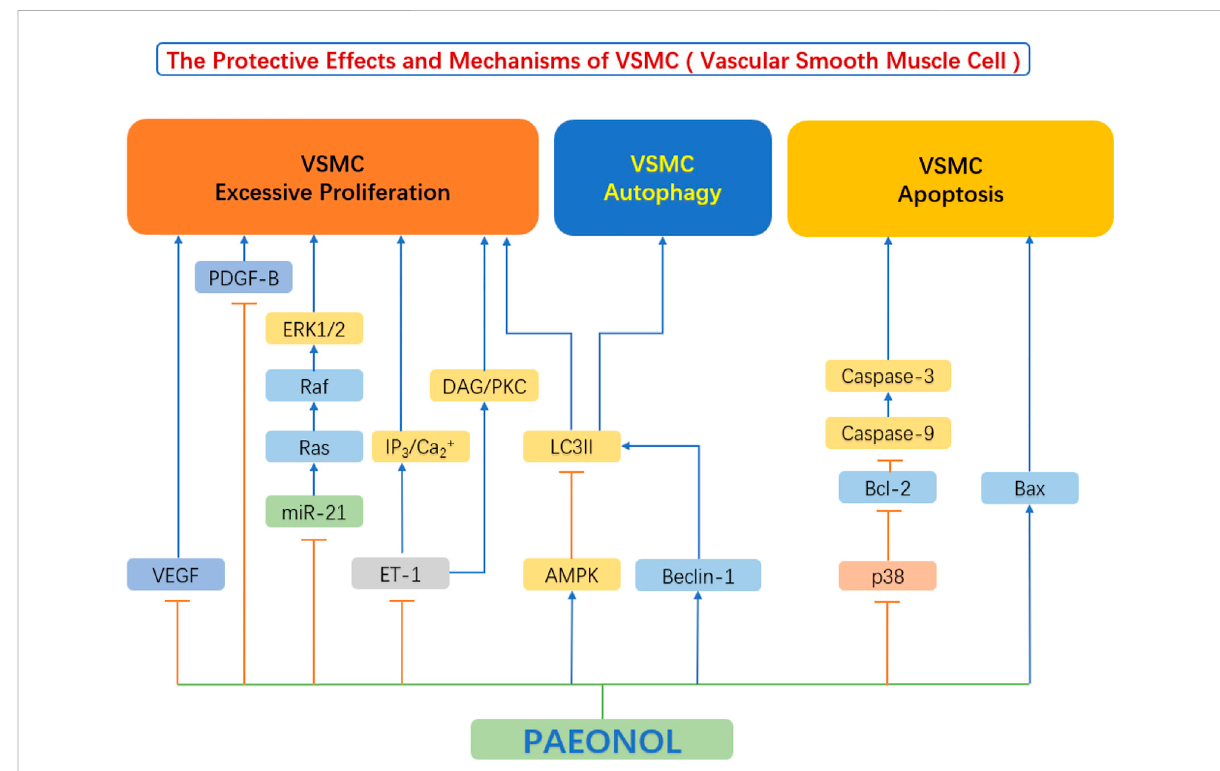
FIGURE 5 The protective effects and mechanisms of paeonol in smooth muscle cells.AMPK, AMP-activated protein kinase; Bax, Bcl-2-associated X protein; Bcl-2, B-cell lymphoma-2;Beclin-1,the mammalian ortholog ofyeast ATG6; Ca, calcium; DAG, diacylglycerols; ERK1/2, extracellular signal regulated kinase 1/2; ET-1, endothelin-1; IP3, inositol 1,4,5-triphosphate; LC3II, light chain 3 II; miR-21, microRNA-21; p38, p38 mitogen-activated protein kinase (MAPK); PDGF-B, platelet derived growth factor B; PKC, protein kinase C; VEGF, vascular endothelial growth